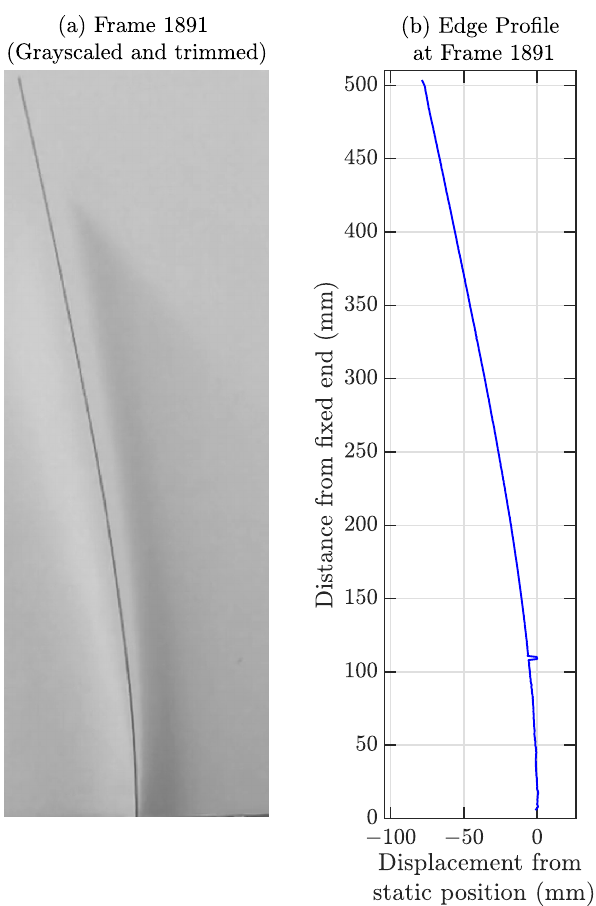
Figure 13. ( a ) Image frame and ( b ) corresponding edge profile for a sample frame (1 inch = 25.4